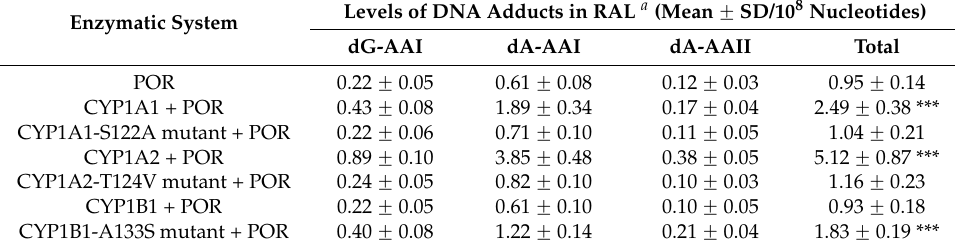
Table 1. AAI-DNA adduct formation catalyzed by human wild-type CYP1A1, 1A2 and 1B1, and their mutants CYP1A1-S122A, CYP1A2-T124V, and CYP1B1-A133S. All CYPs were reconstituted with rat POR in a ratio of 1:1 or with rat recombinant POR alone in liposomes. Levels of DNA Adducts in RAL a (Mean ± SD/10 8 Nucleotides) Enzymatic System